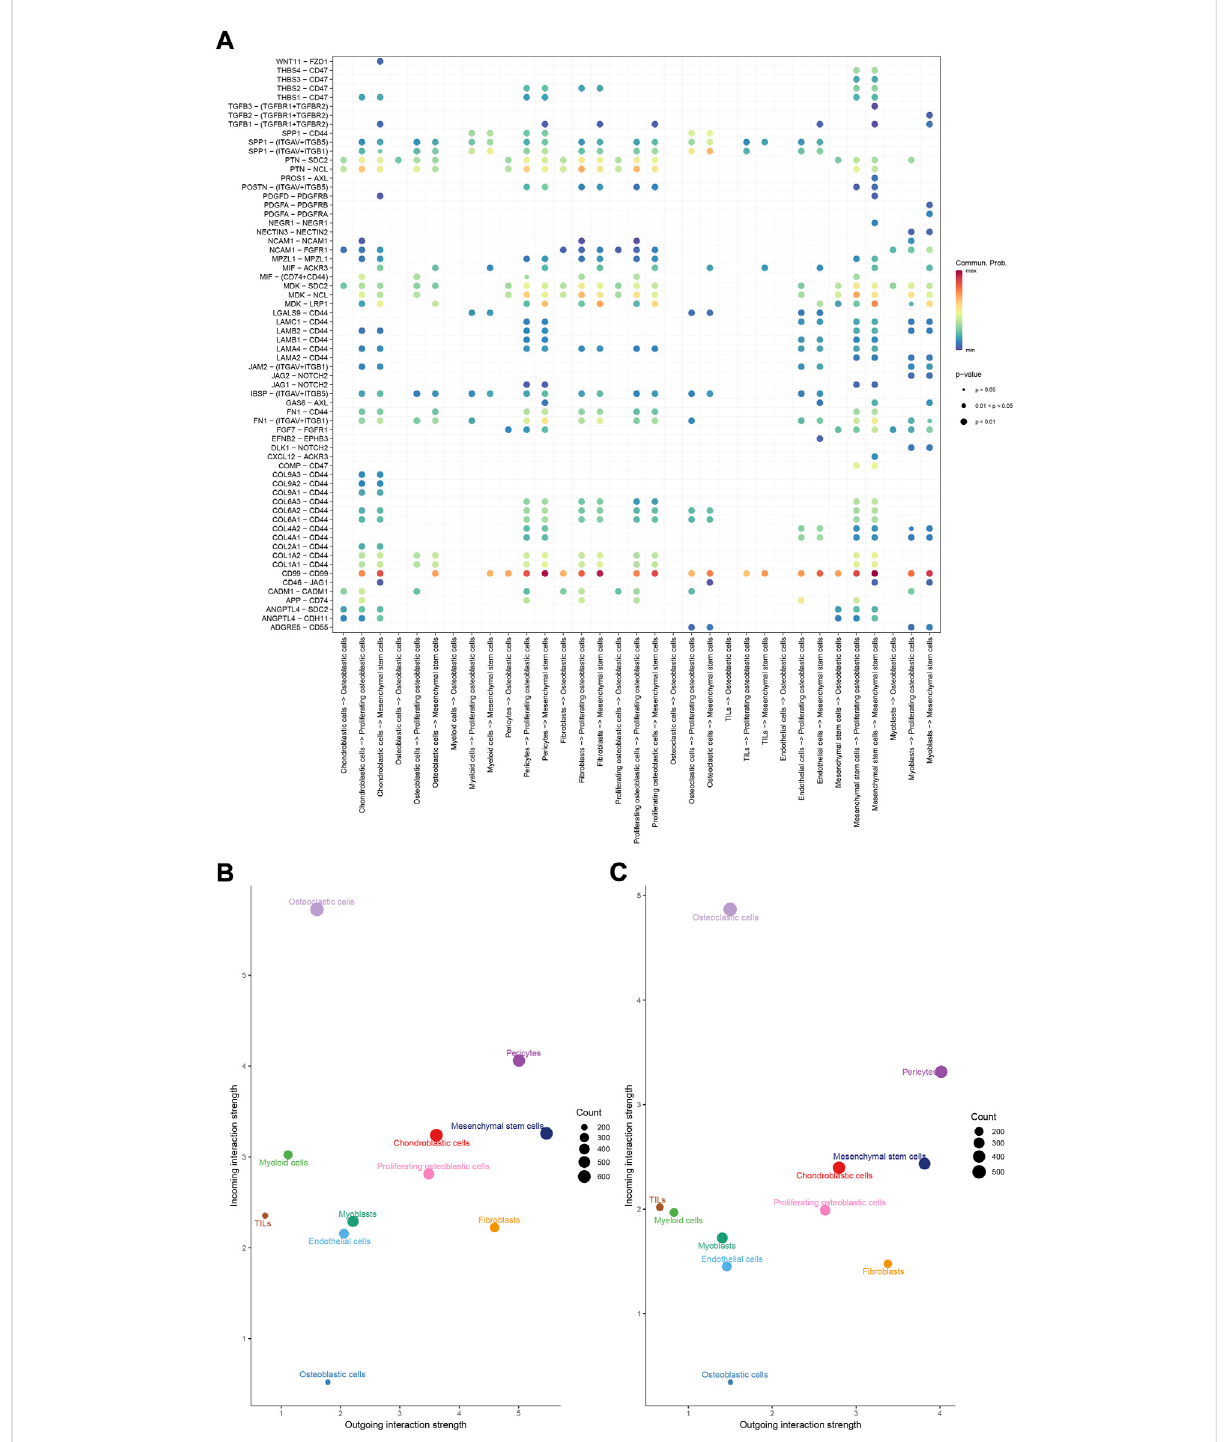
FIGURE 5 Overview of all ligand-receptor interactions of cells in OS. (A) : all ligand-receptor interactions of cells in OS. (B,C) : all signaling pathway networks identi fi ed, selected signaling pathway